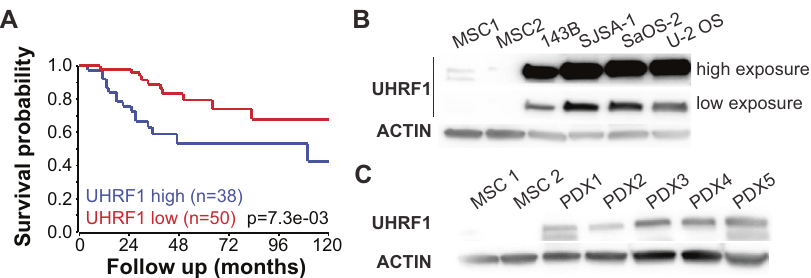
Fig. 1 UHRF1 expression directly correlates with malignancy and metastasis in osteosarcoma. A Overall survival probability of osteosarcoma patients comparing tumors with high UHRF1 (blue, n = 38) versus low UHRF1 (red, n = 50) expression at the time of diagnosis. B , C Western blot analysis of UHRF1 in ( B ) human osteosarcoma cell lines compared to MSC as control and ( C ) PDXs tumors. High exposure was used for UHRF1 detection in MSCs. β -actin was used as a loading